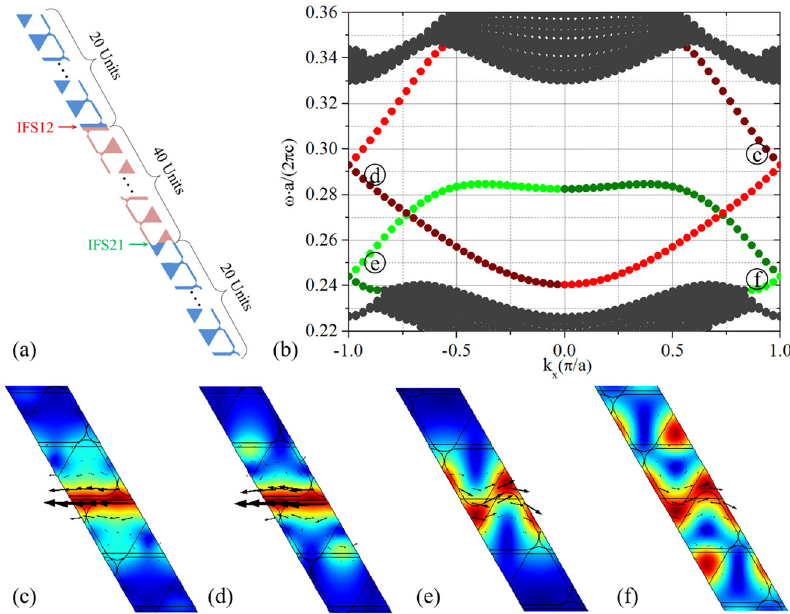
(b). Black arrows denote the Poynting